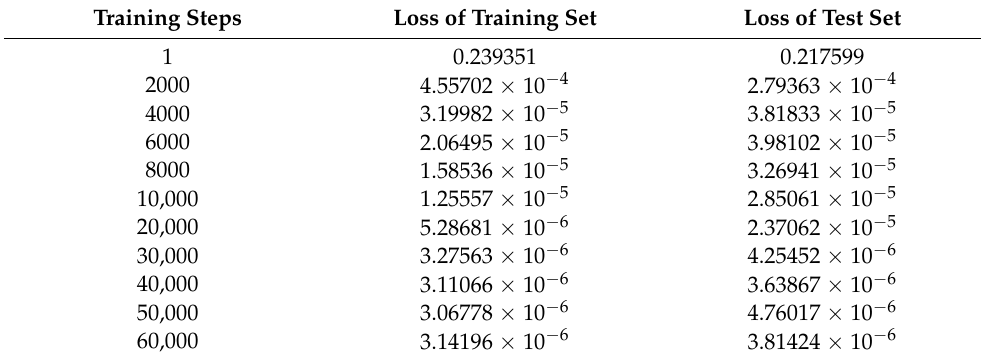
Table 1. Performance metrics of the training set and test set in the training process.